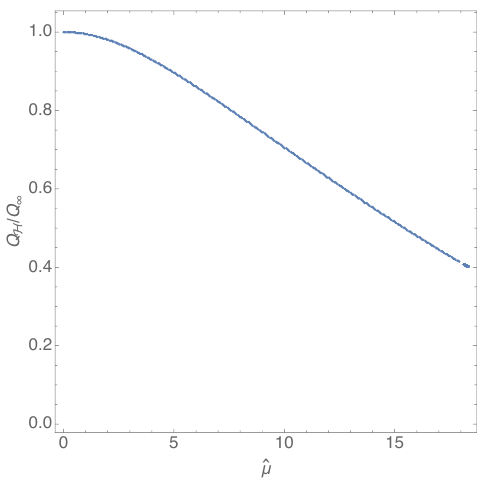
Figure 3 . Ratio of the Maxwell charge measured at the horizon to the Maxwell charge measured at